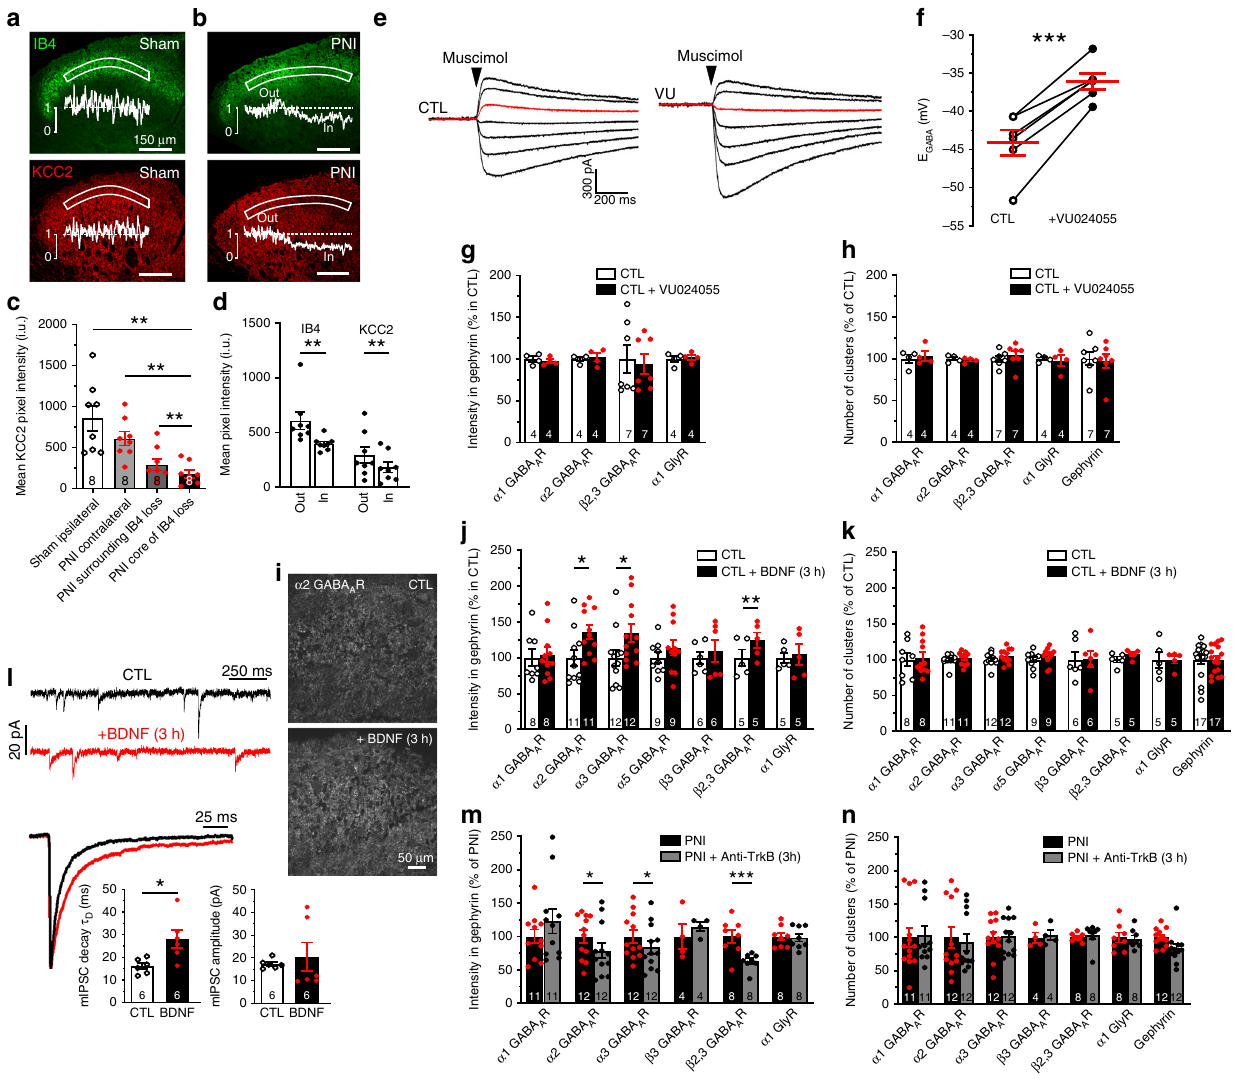
Fig. 3 Replication of the GABAAR subunit switch through BDNF-TrkB signaling, but not by blocking KCC2. a Low magni fi cation confocal acquisitions of IB4 and KCC2 immunostainings in sham SDH and their intensity pro fi les in the SDH b id . in PNI rats. c From left to right, averaged pixel KCC2 immunostaining intensities in the SDH of the L4-L5 lumbar segments of: ipsilateral SDH of shams, contralateral SDH of PNIs, in the surrounding (´out´) and exactly in the region de fi ned by the loss in IB4 labeling that delineates the core of the central projection of lesioned afferents in PNI rats (´in´). d Parallel intensity quanti fi cations of the IB4 and KCC2 immunostaining in the SDH of PNI rats in the same two last regions de fi ned by the loss of IB4 terminals (outside vs. inside). e Currents evoked by muscimol puffs in dorsal horn neurons from control rats or in presence of the KCC2 antagonist (VU0240551 at 15 µ M) applied at increasing 12.5 mV voltage steps ranging from − 93 to − 18 mV. In red the muscimol response recorded at – 43 mV. f E GABA recorded from super fi cial dorsal horn neurons of naive rats in control and in the presence of VU0240551 (-44.1 ± 1.7 mV, CTL; -36.1 ± 1 mV, VU; n = 6 cells). g Antagonizing KCC2 did not modify the synaptic location at inhibitory sites of GABA A Rs and GlyRs. h Blocking KCC2 did not affect the number of clusters of the α 1, α 2 or β 2,3 GABA A R nor of the α 1 GlyR or gephyrin. i Example of the synaptic α 2 GABA A R expression increase in control spinal cord slices incubated in 50 ng·ml -1 BDNF in arti fi cial cerebrospinal fl uid (ACSF) for 3 h. j The quanti fi cation of the synaptic GABA A R subunits showed an increase in synaptic α 2, α 3 and β 2,3 GABA A R subunits in BDNF-treated slices. The synaptic expressions in α 1, α 5 GABA A R and α 1 GlyR remained unchanged with BDNF treatment. k BDNF however did not modify the number of inhibitory synapses by itself. l Examples of GABA A mIPSC traces recorded from control lumbar spinal cord slices incubated in ACSF with or without BDNF and averaged mIPSC aligned by rise time and y-scaled by amplitude. The incubation in a BDNF-containing ACSF signi fi cantly prolonged the decay time of the GABA A mIPSC currents in dorsal horn neurons but did not signi fi cantly modify their mean amplitude. m Blocking BDNF-TrkB signaling with an anti-TrkB antibody in PNI spinal cord paired-sections (2 μ g ml − 1 in ACSF for 3 h) was able to reverse the GABA A R synaptic over-expression and phenotypic switch in PNI rats, n but did not modify the number in GABA A R, GlyR or gephyrin clusters. Numbers of rats are indicated at the bottom of each bar; CTL, control rat. (* P < 0.05; ** P < 0.01; *** P < 0.001). Source data is available as a Source Data fi